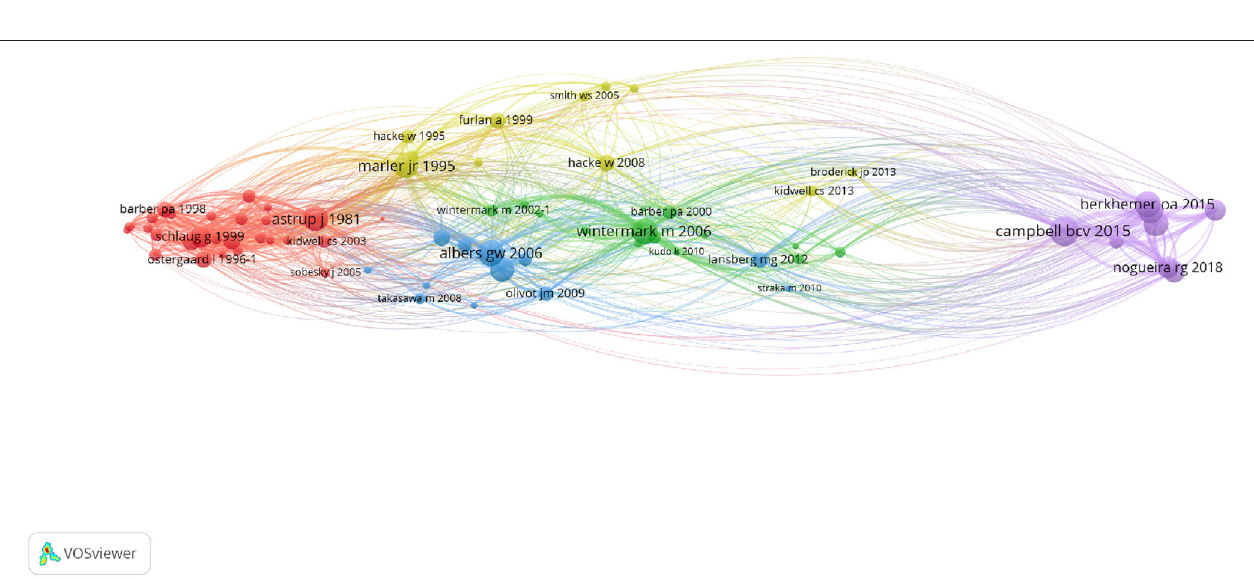
FIGURE 5 | Co-citation network providing an overview of the acute ischemic stroke research field evolutions through its most contributing publications: Red cluster [1981–2005]: MRI diffusion-perfusion mismatch; Green cluster [2000–2013]: perfusion CT; Blue cluster [2003–2012]: Eligibility for thrombolysis; Yellow cluster [1995–2013]: Thrombolysis combined to endovascular therapies; Purple cluster [2015–2018]: Mechanical thrombectomy. MRI, magnetic resonance imaging; CT, computed tomography.